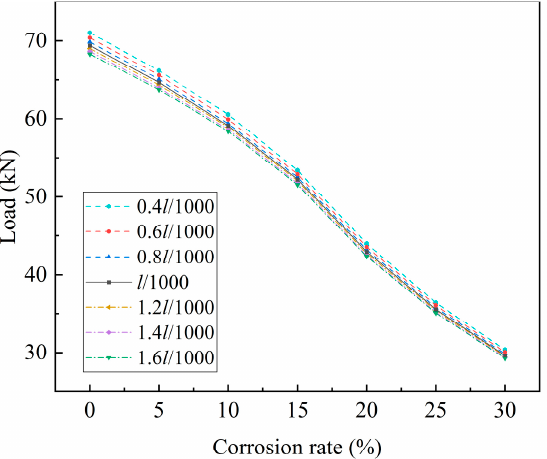
Figure 20. Overall Stability Ultimate Bearing Capacity of the Data Model